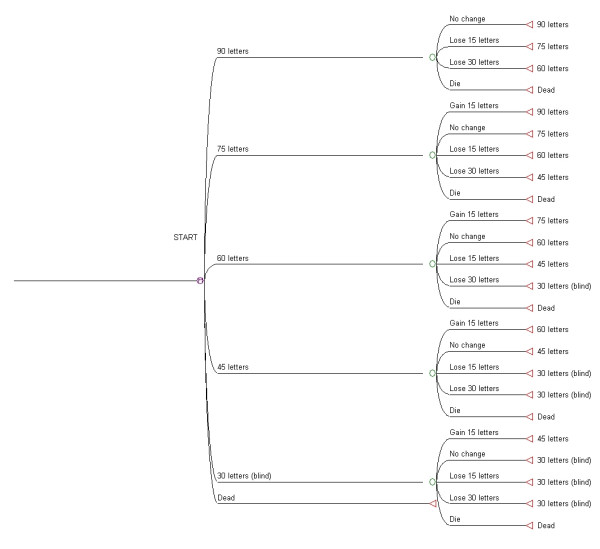
Simplified diagram of Markov tree model, which was analysed for the Ranibizumab treatment strategy and the No ranibizumab treatment strategy.